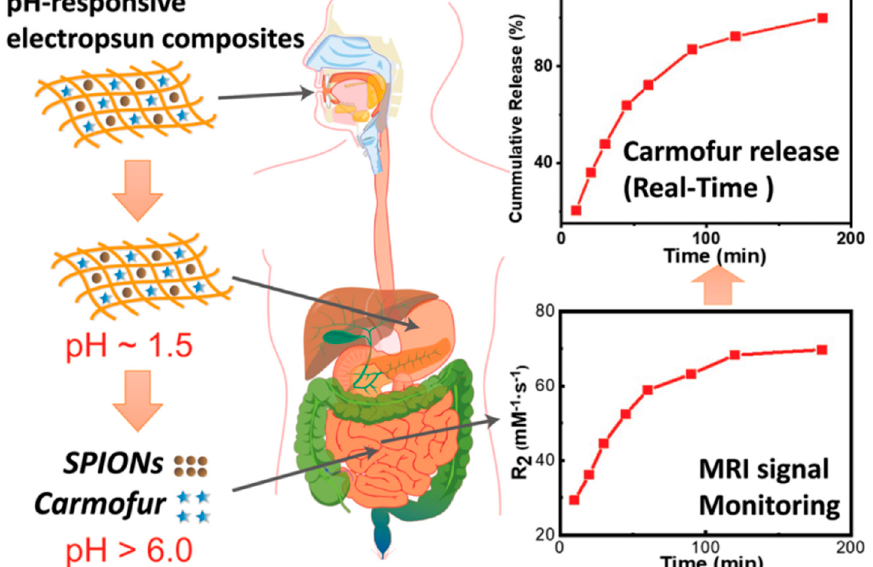
Figure 14. Strategic underpinning nanoplatform design of pH-responsive NFs allowing MRI moni- toring of drug release. Reproduced with permission from [101], CC BY license, Copyright © 2021, The Royal Society of Chemistry.